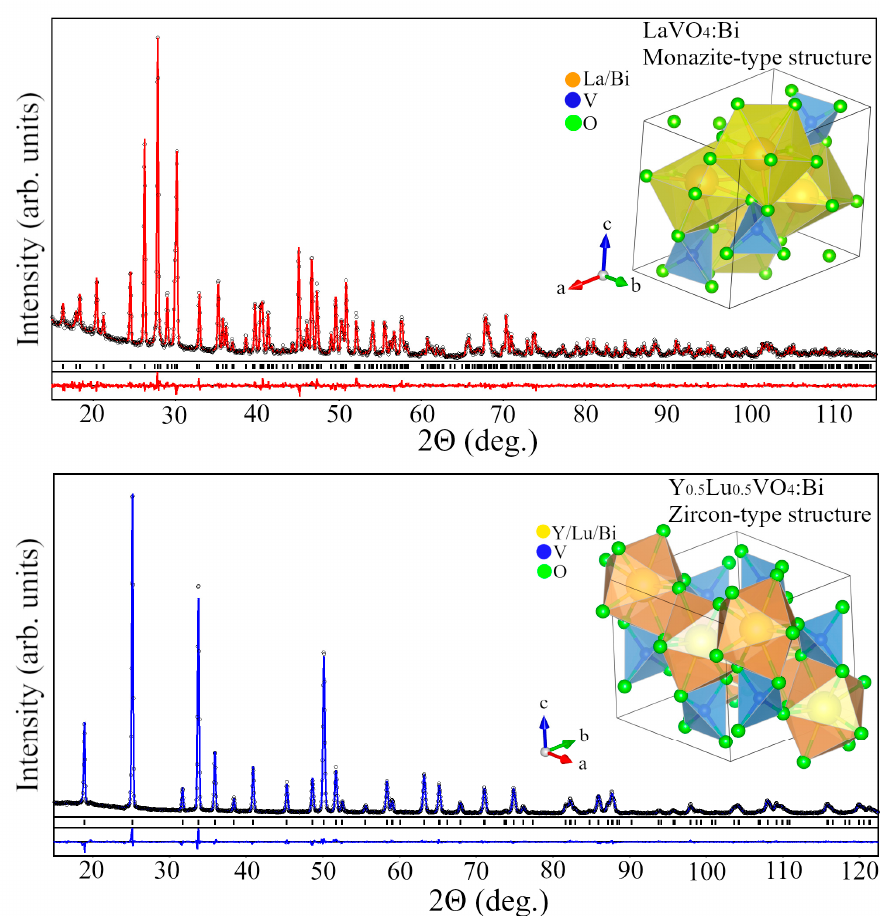
Figure 5. Graphical results of Rietveld refinement of Bi-doped LaVO 4 ( top ) and Y 0.5 Lu 0.5 VO 4 ( bottom ) structures. Experimental XRD patterns (black circles) are shown in comparison with the calculated profiles (red and blue lines, respectively). Short vertical bars on the top and bottom panels indicate positions of Bragg’s maxima in the monoclinic P 2 1 / n and tetragonal I 4 1 / amd structures, respectively. Insets shows polyhedral views of monazite-type LaVO 4 :Bi and zircon-type Y 0.5 Lu 0.5 VO 4 :Bi structures.